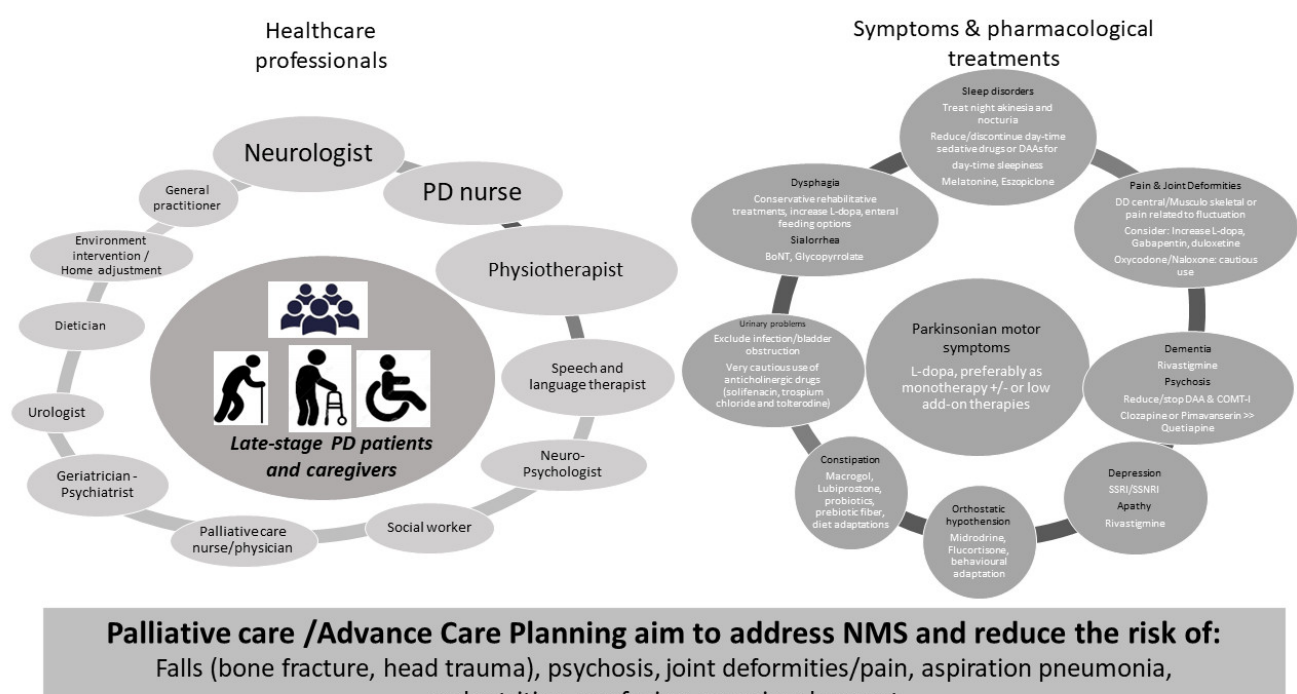
Figure 1. Pillars for Late-stage PD treatment. Left panel: health care professionals involved in LSPD management. Right panel: motor and NMS and available pharmacological options. Bottom: the main objectives of prevention strategies for LSPD patients. COMT − I: Catechol − O-methyl transferase inhibitors; DAAs: dopamine-agonist; SSRI/SNRI: selective serotonin reuptake inhibitor/serotonin and norepinephrine reuptake inhibitor.